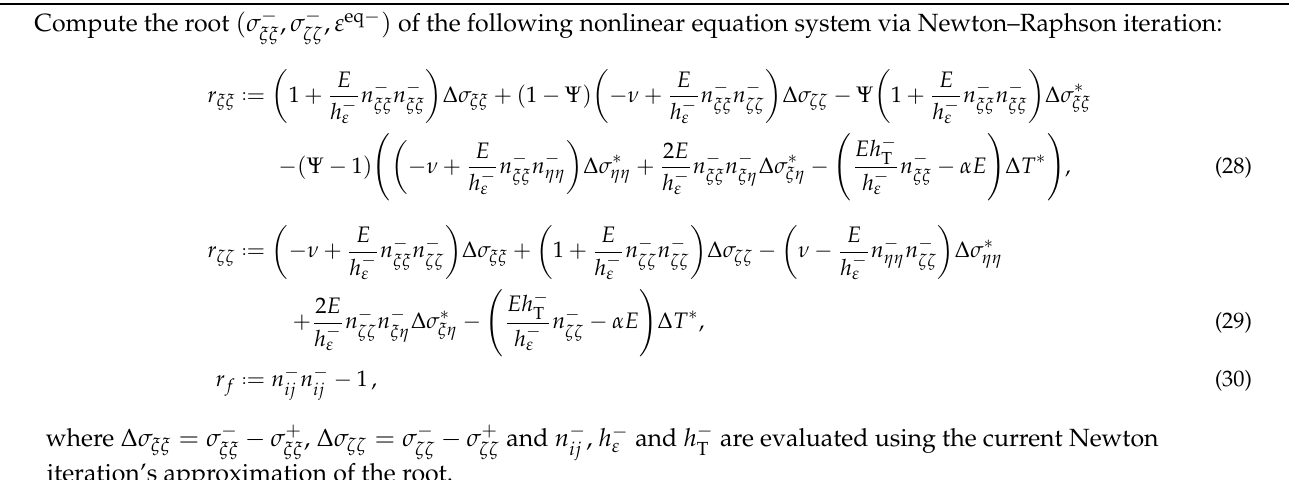
Algorithm 2: Implicit integration of stresses and equivalent plastic